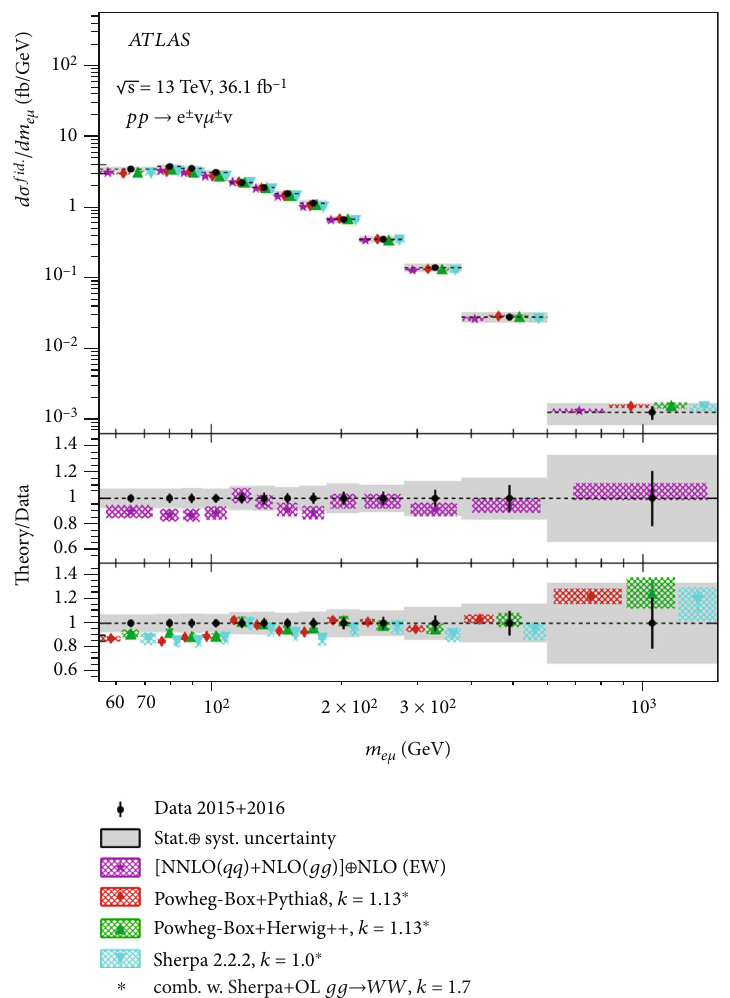
Figure 1: An example of a precise determination of a kinematic distribution (invariant mass of the two leptons in W + W − production) and its comparison with di ff erent theoretical calculations and showering tools. Figure from Ref.